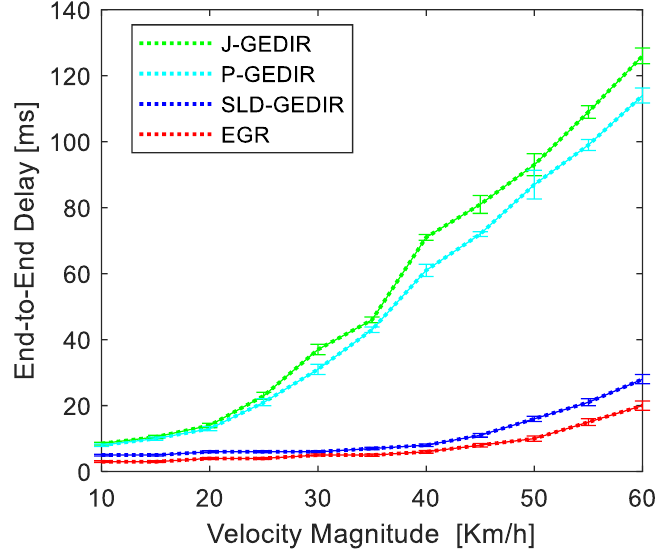
Figure 11. Effect of velocity on end-to-end delay.